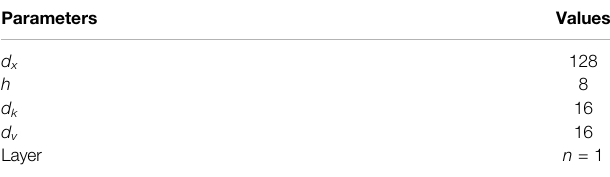
TABLE 3 | Word vector.